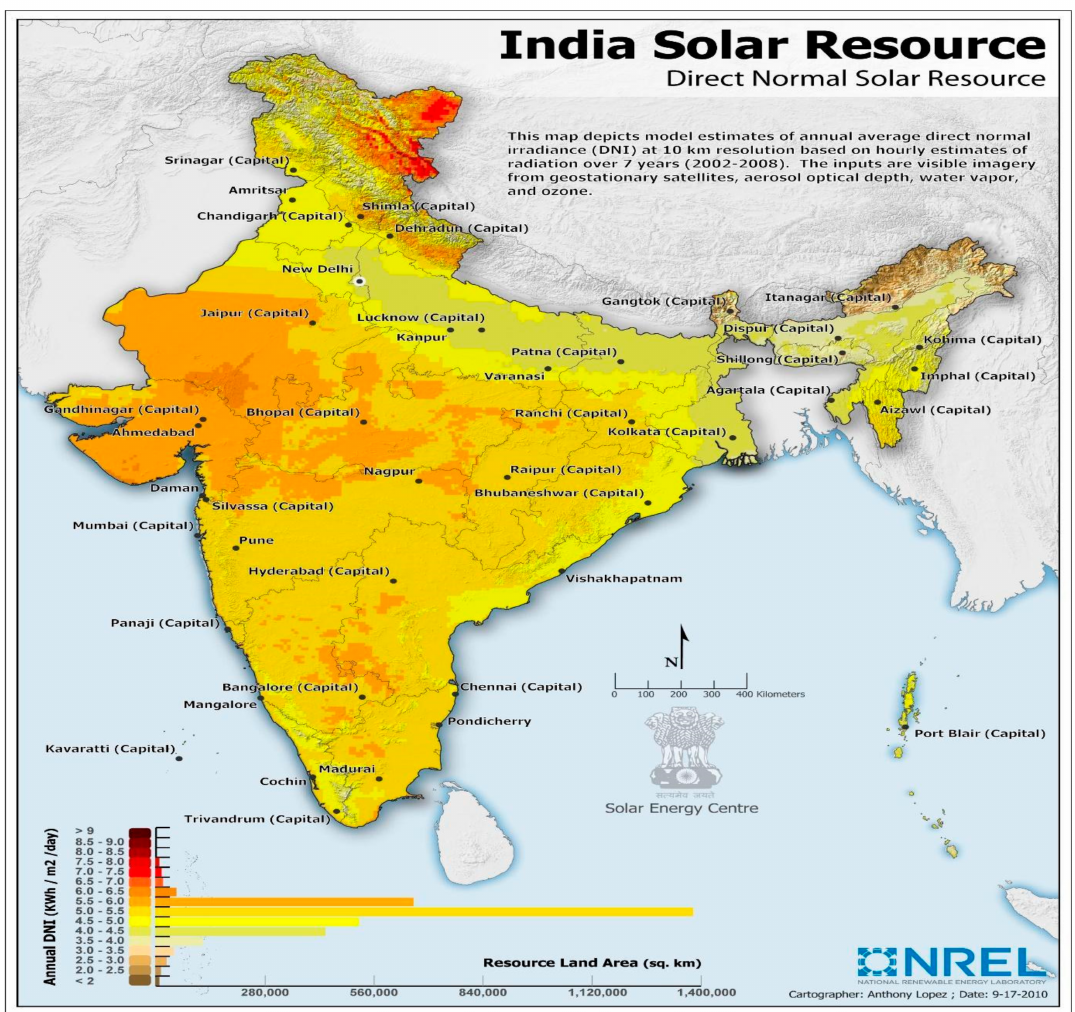
Figure 9. Amount of solar insolation in India on average showing areas of extreme heat which may be considered in the calculations of energy payback time. (Taken from NREL solar radiation